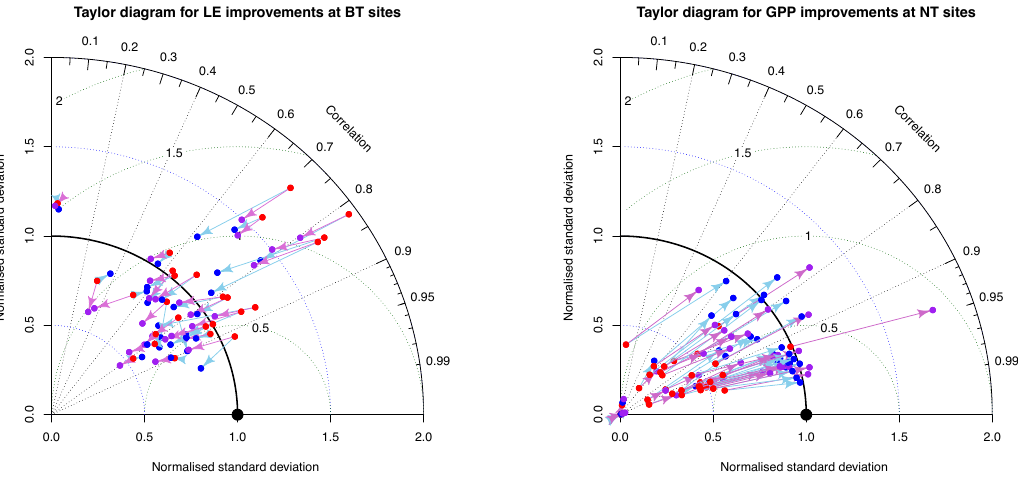
Figure 6. Improvements in fit represented by “Taylor diagrams”. Observed time series (black dot) can be compared with modelled time series for default parameters (red dots), site-specific optimal parameters (blue dots) and PFT-generic optimal parameters (purple dots). √ Radial distance from the origin (dotted lines) represents normalised standard deviation var ( m t )/ var ( o t ) , and so a modelled time series with the correct variance lies on the thick black line. Angular position represents the correlation between modelled and observed time series. √ The distance from the black dot (dotted green lines) represents the normalised standard deviation in the errors var ( o t − m t )/ var ( o t ).